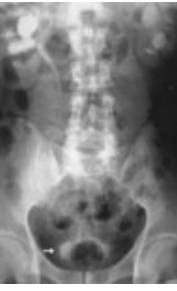
FIGURE 3 . A filling defect on the right side of bladder in second